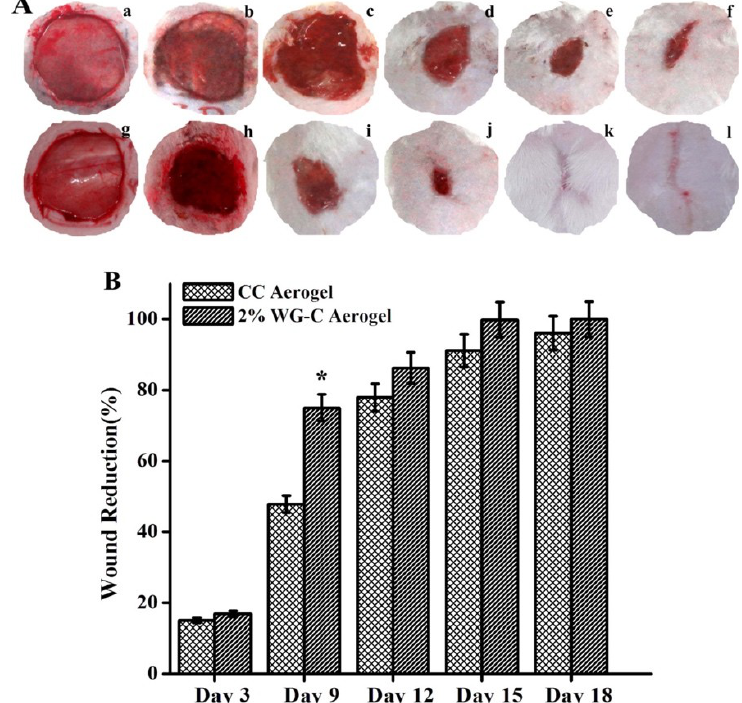
Figure 19. ( A ) Wound healing study where a–f (top row) show the collagen control aerogel at day 0, 3, 9, 12, 15, and 18 and g − l (bottom row) show the 12% collagen-wheat grass aerogel at day 0, 3, 9, 12, 15, and 18. Image ( B ) shows the wound healing as a percent of wound reduction. Adapted from [205] with permission, copyright American Chemical Society, 2017.